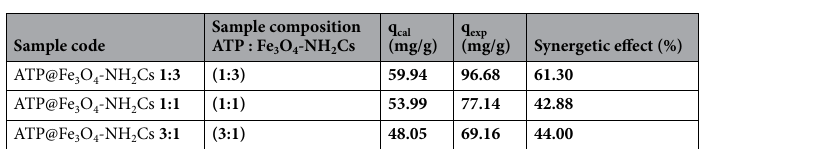
Table 1. Synergetic effect of ATP clay to Fe 3 O 4 -NH 2 Cs in the removal of Cr(VI).